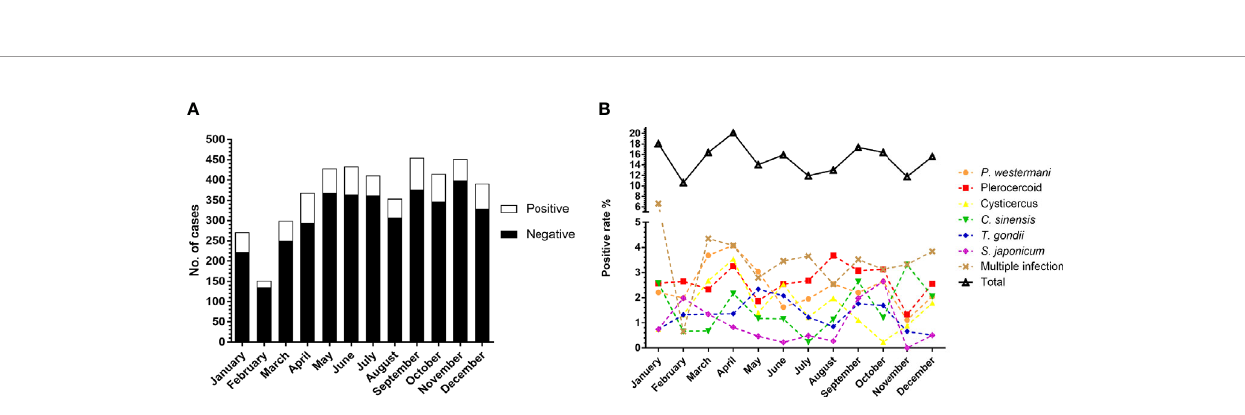
FIGURE 5 | Comparison of the prevalence of parasites between months. (A) Number of cases received and results in different months. (B) Comparison of the prevalence of total parasites and the six most commonly detected parasites among the months.